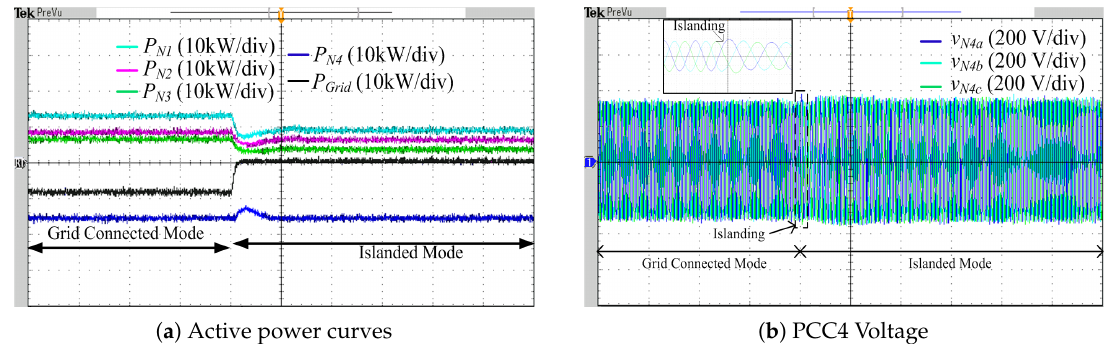
Figure 12. Transition of microgrid during grid connected to islanded operating mode.